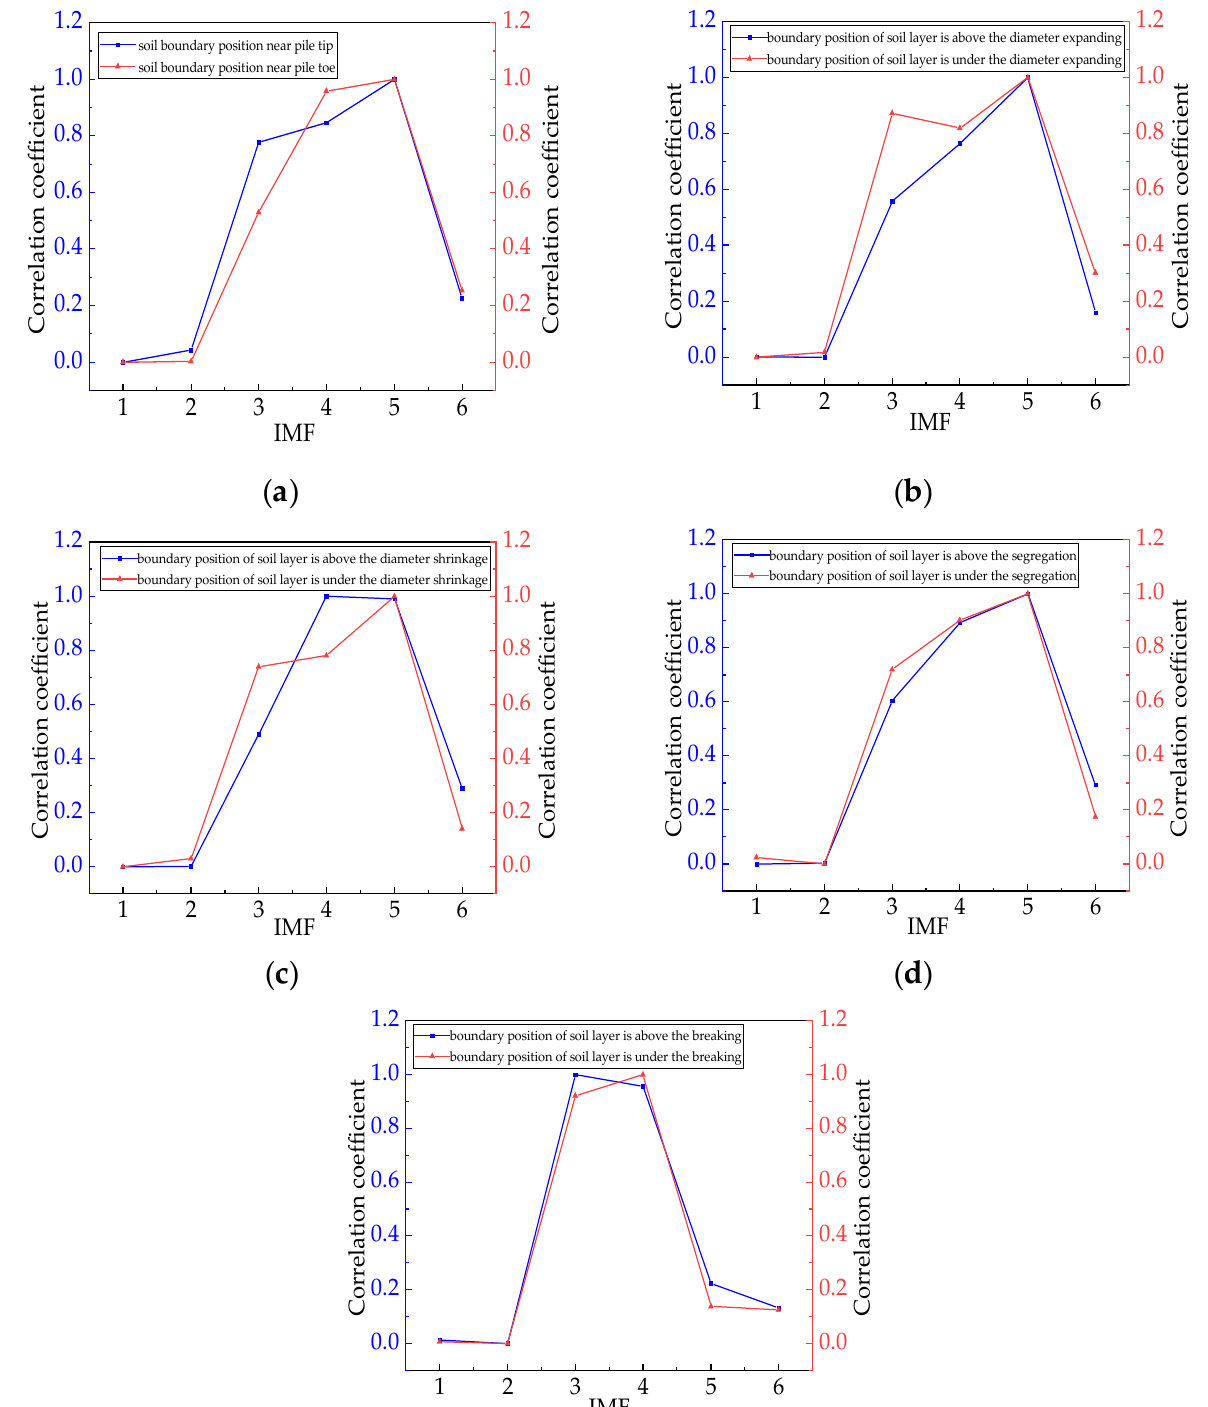
Figure 11. Correlation analysis variation tendency: ( a ) Complete pile dynamic signal ICEEMDAN decomposition; ( b ) Diameter expanding piles dynamic signal ICEEMDAN decomposition; ( c ) Diameter shrinkage piles dynamic signal ICEEMDAN decomposition; ( d ) Segregation pile dynamic signal ICEEMDAN decomposition; ( e ) Pile breaking dynamic signal ICEEMDAN decomposition. Time series complexity is measured using sample entropy [45]. The calculation for the original time series X = {x 1 ,x 2 , . . . ,x N } see below for